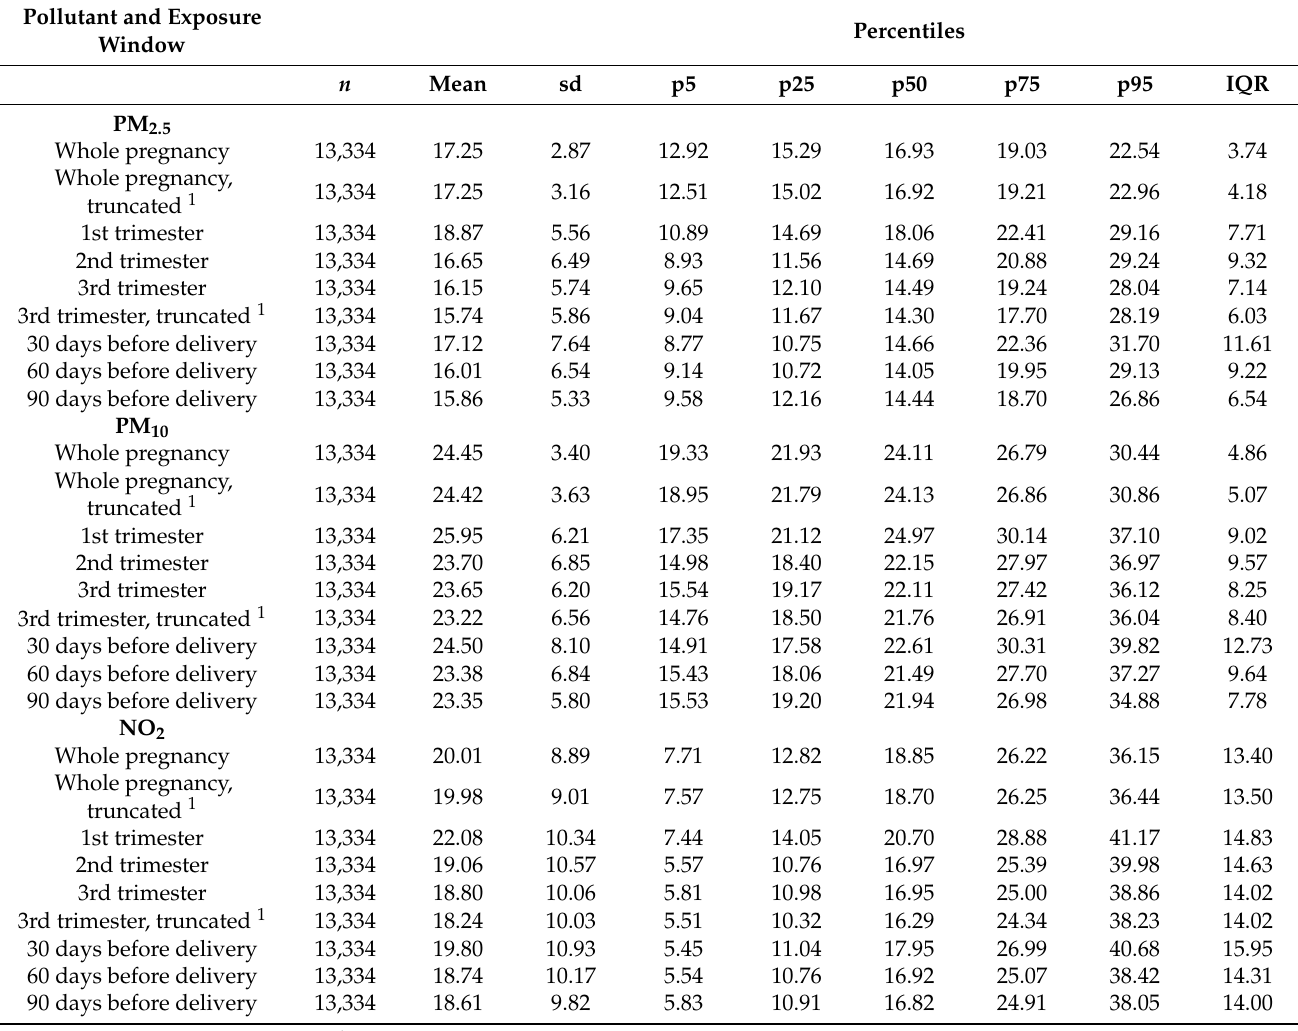
Table 2. Characteristics of the whole ELFE cohort ( n = 17,358), and of the subpopulations included ( n = 13,334) and excluded ( n = 4024) from this study (all groups were restricted to term births, our target population). Pollutant and